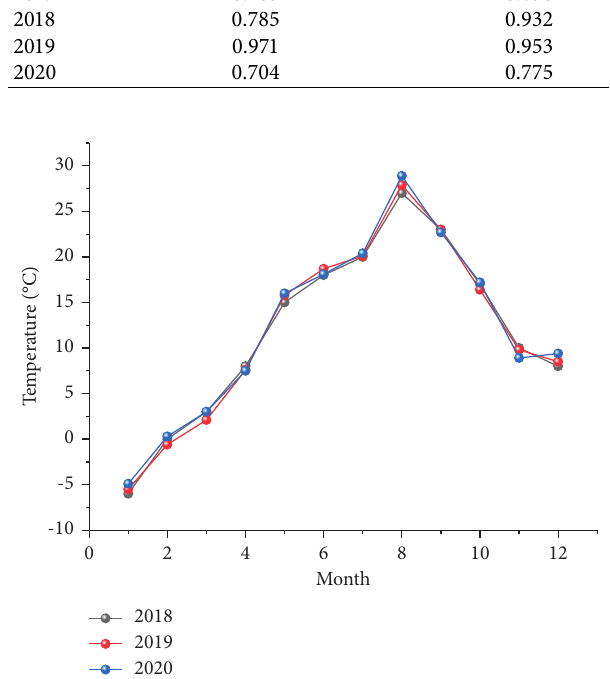
Figure 1: Monthly variation of sea temperature in the South Atlantic